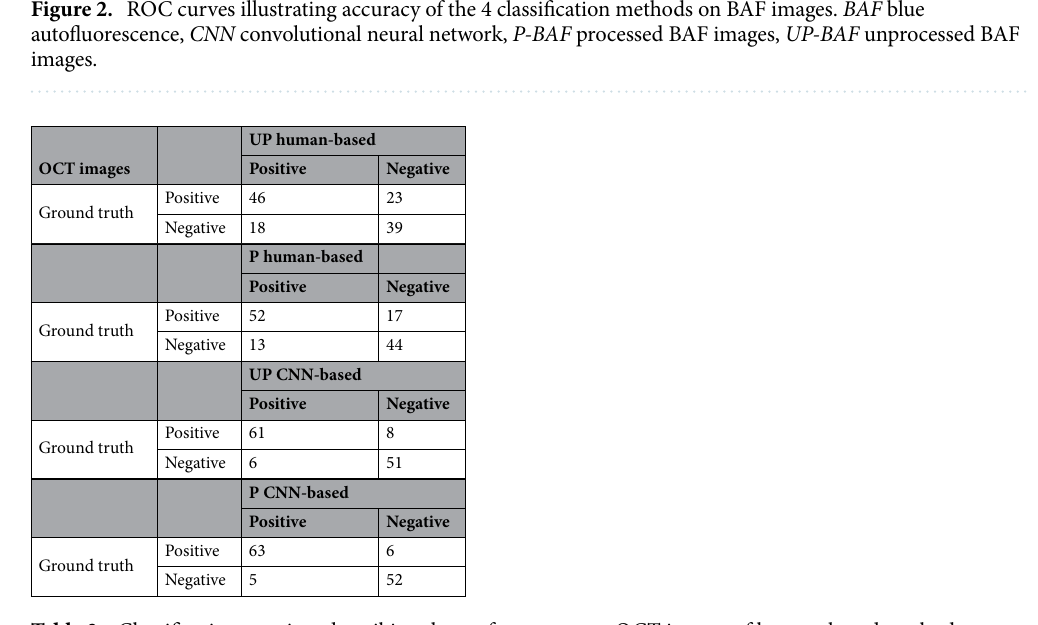
Table 2. Classification matrices describing the performances on OCT images of human-based methods on both unprocessed (UP) and processed (P) images and CNN-based methods on both UP and P images. CNN convolutional neural network, OCT optical coherence